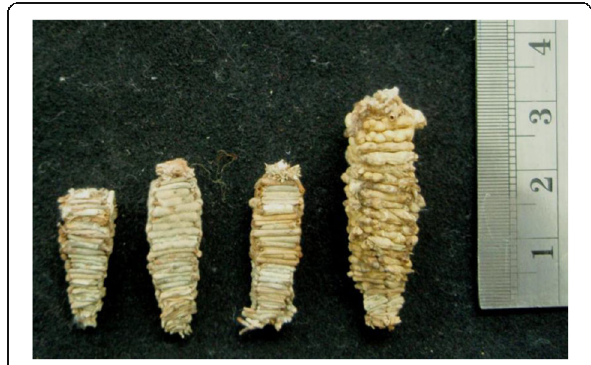
Fig. 1 Sacs built from white broom plant parts by larvae of A. quadrangularis (right: female sac; others: male sacs)